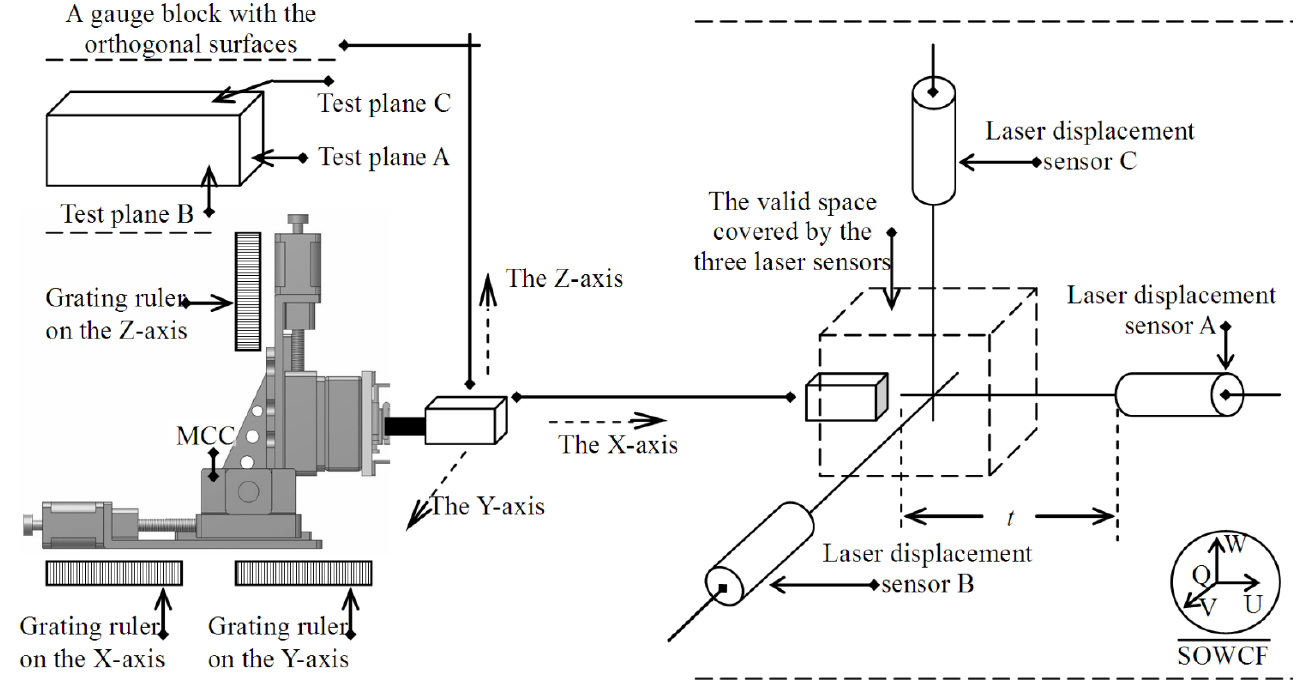
Figure 2. The setup to estimate the intersection angles of the coordinate axes of the motion trajectory coordinate frame, where SOWCF = standard orthogonal world coordinate frame.